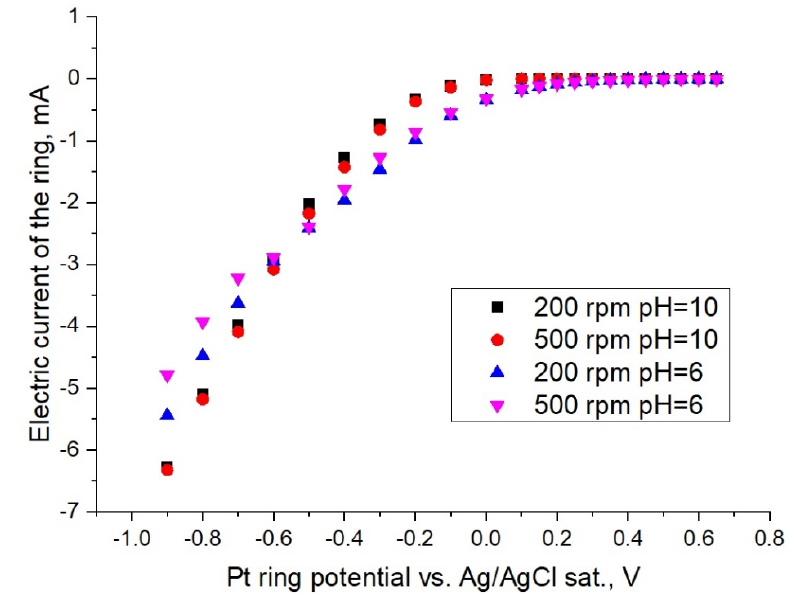
Figure 4. The Pt ring collected current vs. the potential dependence under stationary conditions for 0.1 M NaBrO 3 in various buffer solutions at RRDE different rotation velocities.